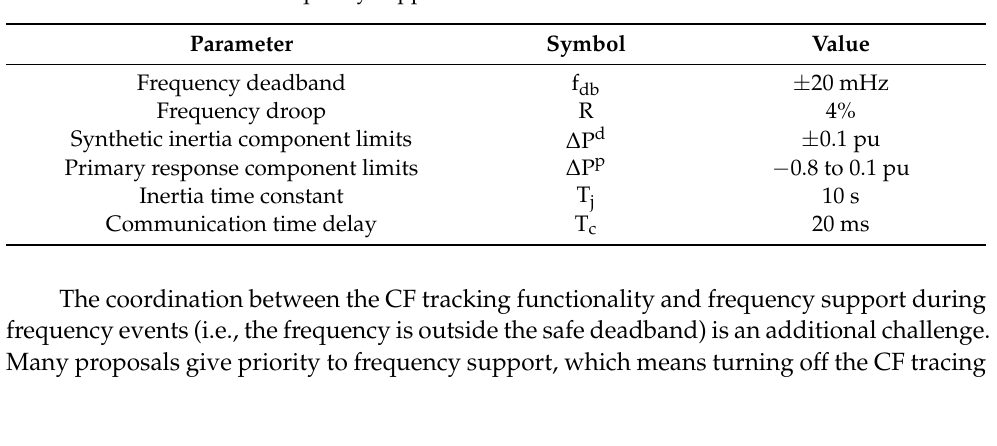
Figure 1. Frequency support controller of the BESS. Table 1. Parameters of the frequency support controller of